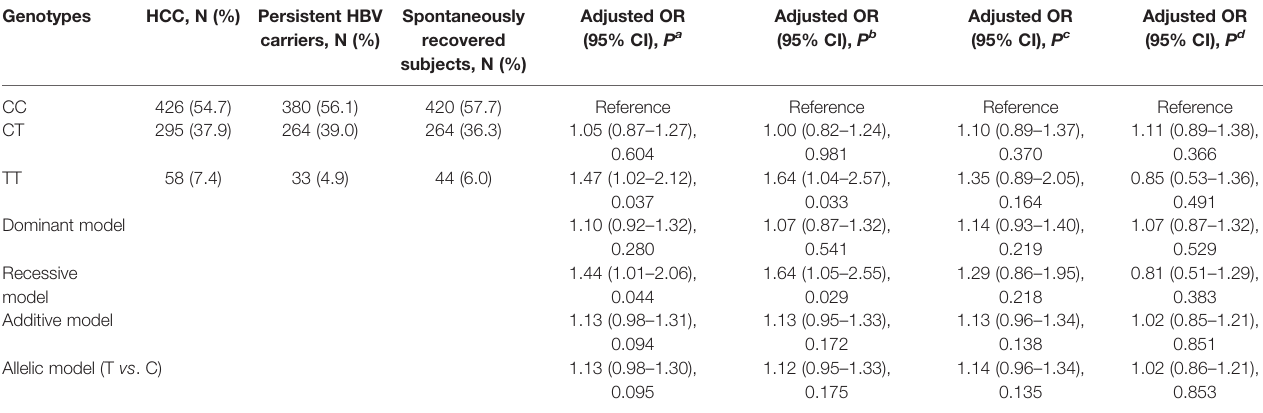
TABLE 2 | The effects of MBOAT7-TMC4 rs641738 on persistent HBV infection and HCC. Genotypes